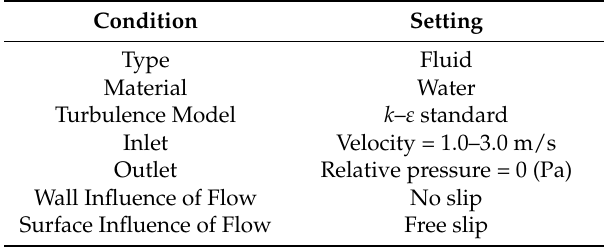
Table 2. Conditions of analysis in